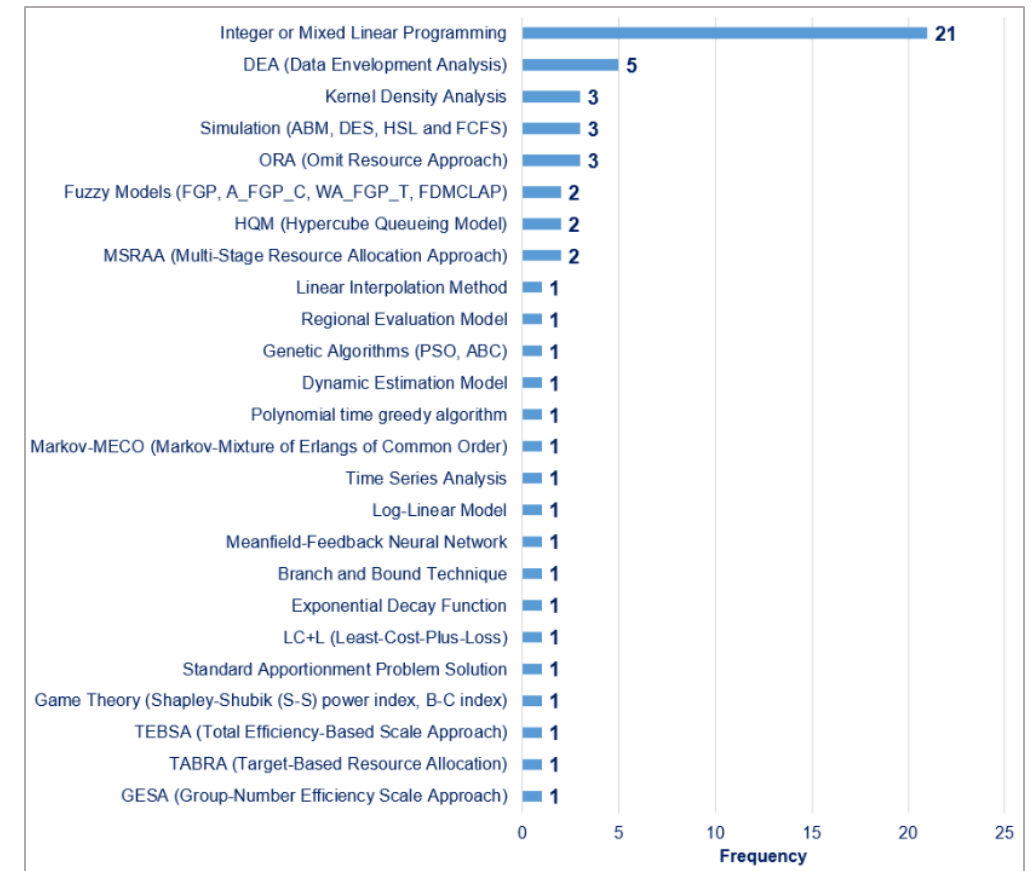
Figure 2. The frequency of the mathematical models used for RAFD.